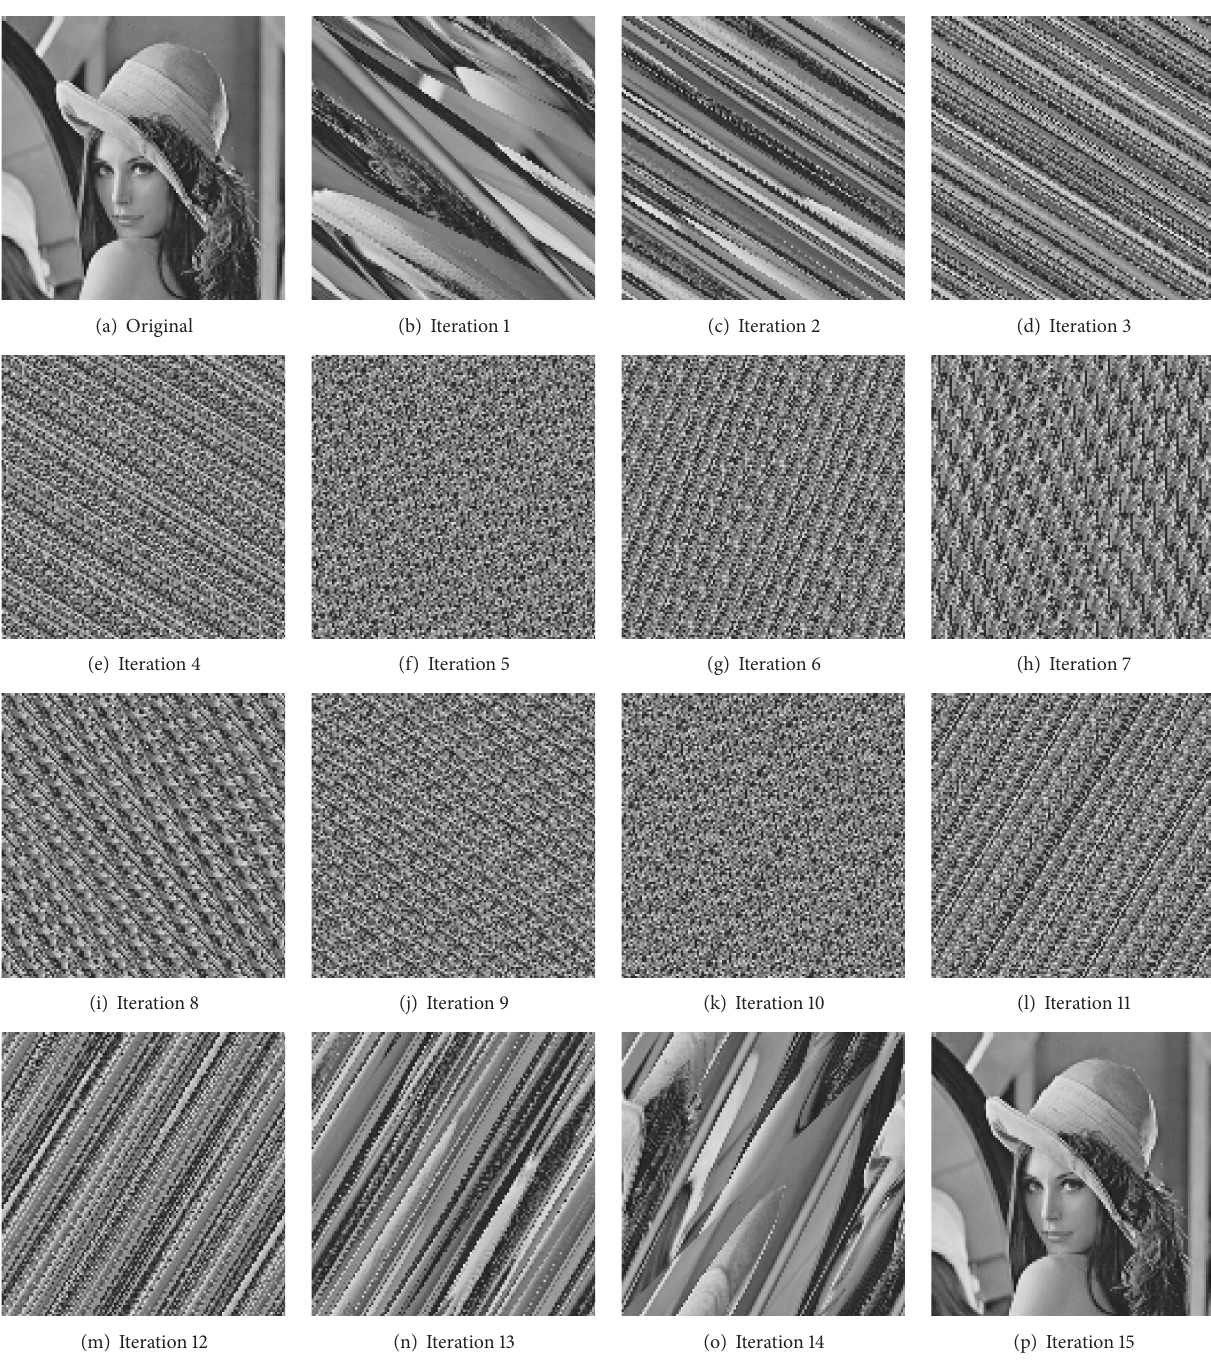
Figure 3: Encryption results with Arnold’s cat